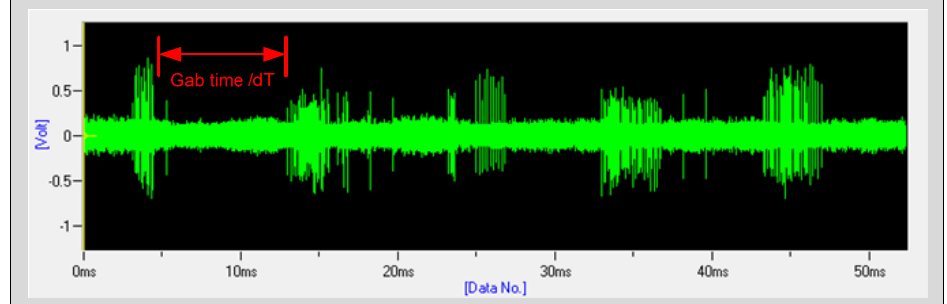
Figure 8. the PD signal waveform from HFCT